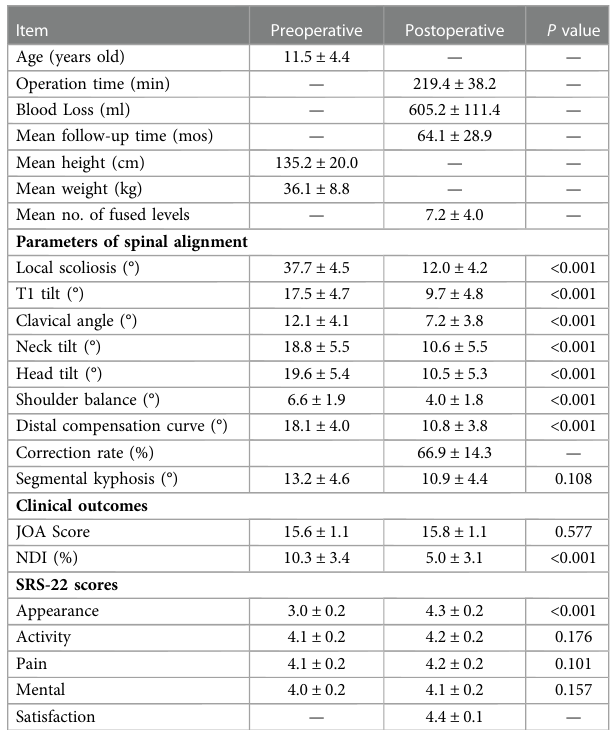
TABLE 1 Clinical evaluations in Type IA patients (mean±SD).